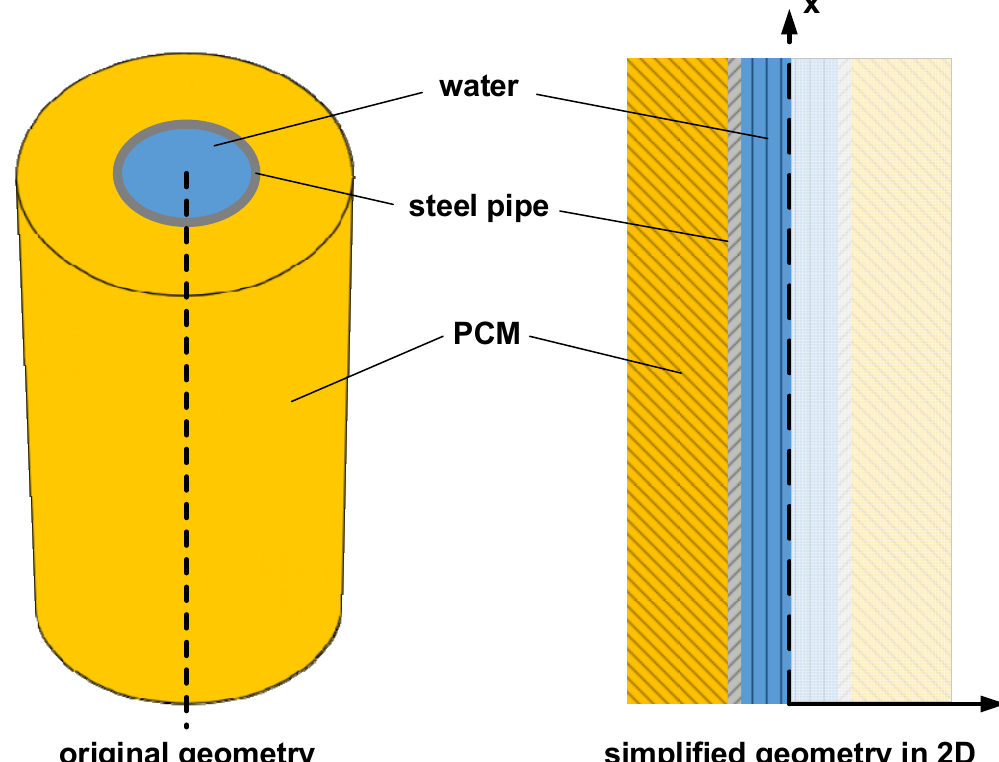
Figure 2. Original and simplified geometry used in the numerical simulation.